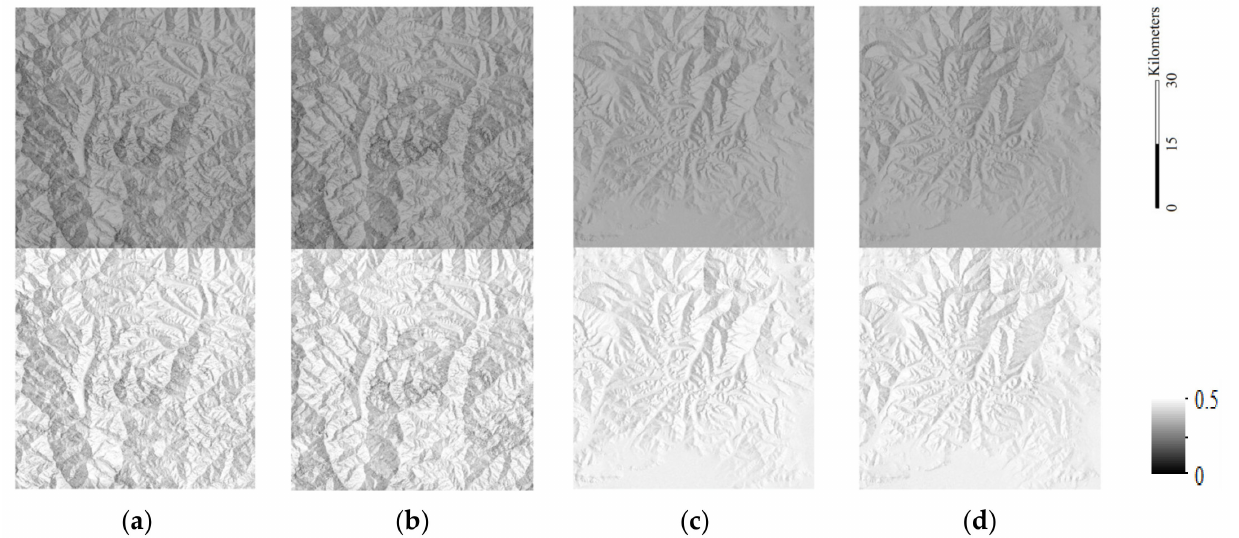
Figure 8. The LESS simulation results in two scenes with 30 ◦ and 270 ◦ solar azimuth angle (SAA). They are in NIR band, in 30 m resolution with 3800 × 1900 pixels. The upper area has soil reflectance property (lower reflectance), while the nether area has leaf reflectance property (higher reflectance). ( a ) is scene 1 with 90 ◦ SAA; ( b ) is scene 1 with 270 ◦ SAA; ( c ) is the scene 2 with 90 ◦ SAA; ( d ) is scene 2 with 270 ◦